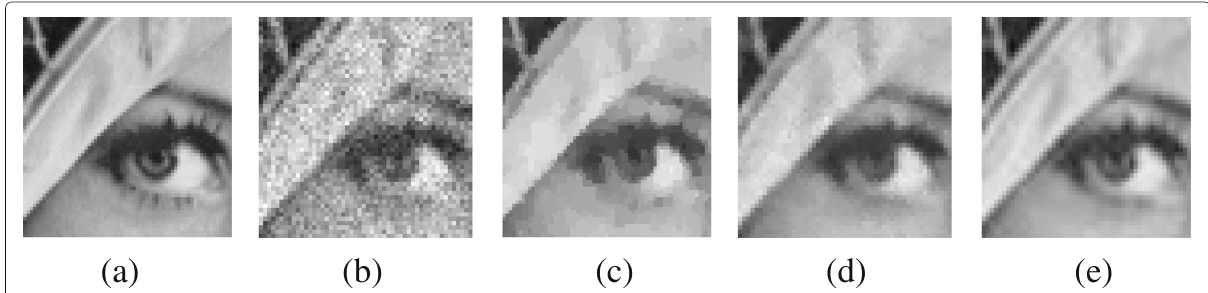
Fig. 9 A part of the “Lena” image with discontinuities; a true image; b noisy image ; c processed with method M1; d processed with method M2; e processed with method